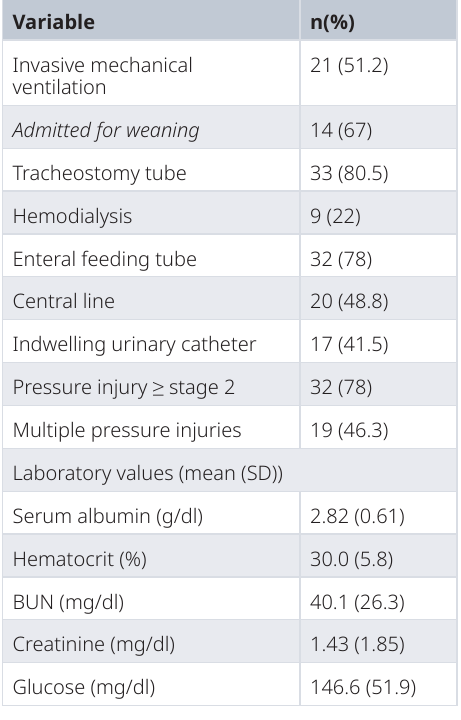
Table 2. Status of post-COVID recovery patients on admission (n=41).